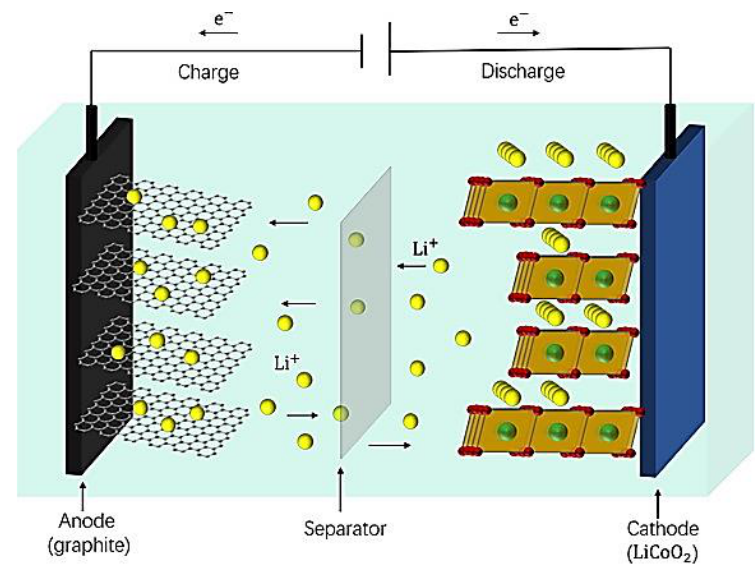
Figure 1. Schematic illustration of LIBs